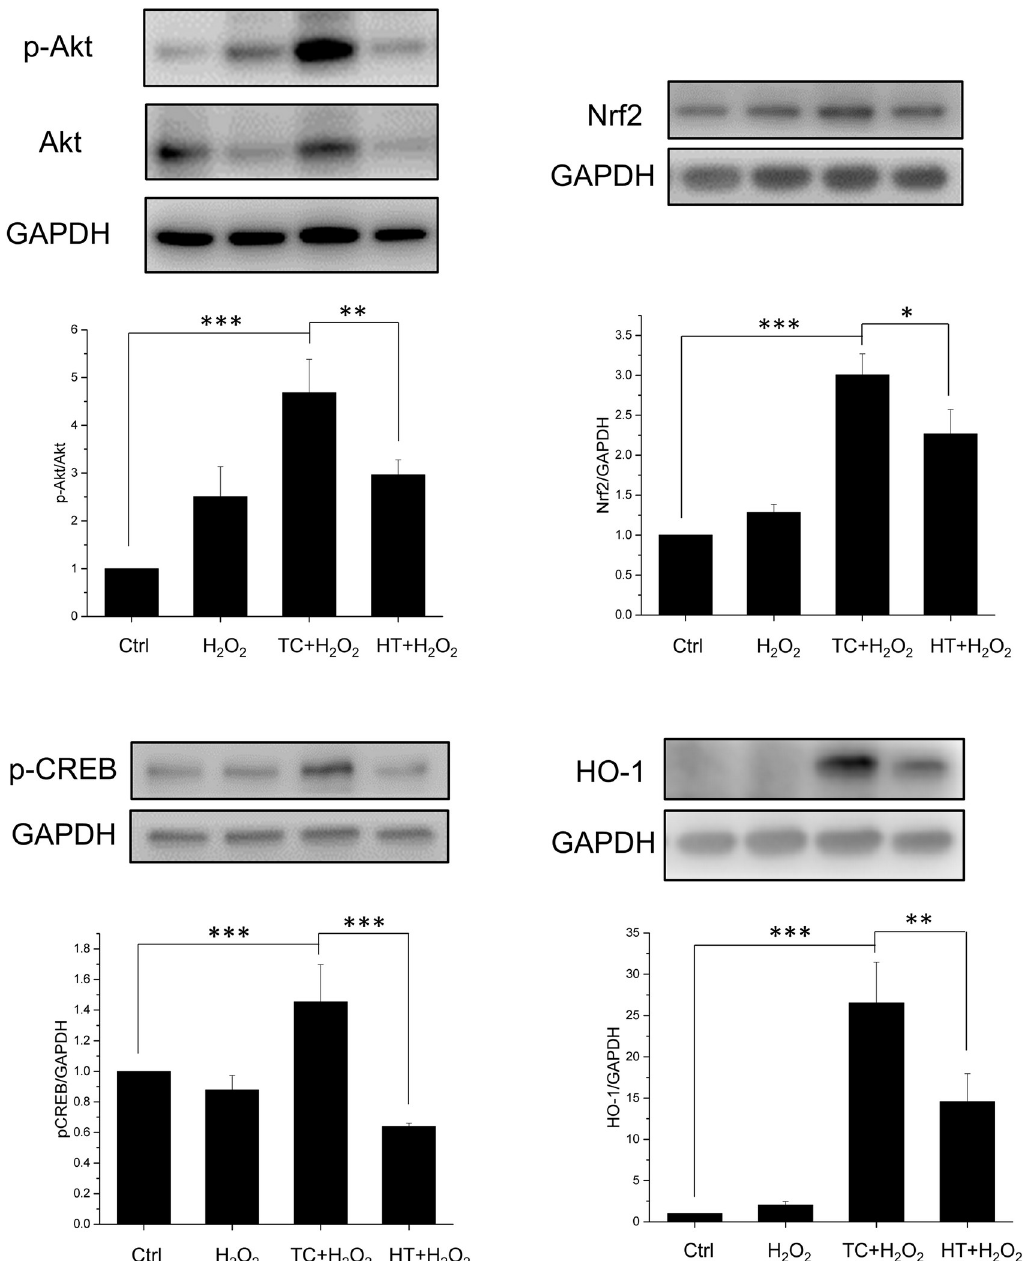
Fig 8. Effect of TC-HT on Akt/Nrf2 and Akt/CREB signalling pathways and related protein expressions. Cells were lysed 15 h after H 2 O 2 treatment for p-Akt, Akt, Nrf2, p-CREB proteins, and lysed 18 h after H 2 O 2 treatment for HO-1 protein, and western blot analyses of p-Akt, Akt, Nrf2, p-CREB, and HO-1 proteins were performed. Quantification of p-Akt, Nrf2, p-CREB, HO-1 expressions after H 2 O 2 , TC+H 2 O 2 , or HT+H 2 O 2 treatment. The expression level of p-Akt was normalized to total Akt while other proteins were normalized to GAPDH. Data represent the mean ± standard deviation (n = 3). ��� P < 0.001, �� P < 0.01 and � P <